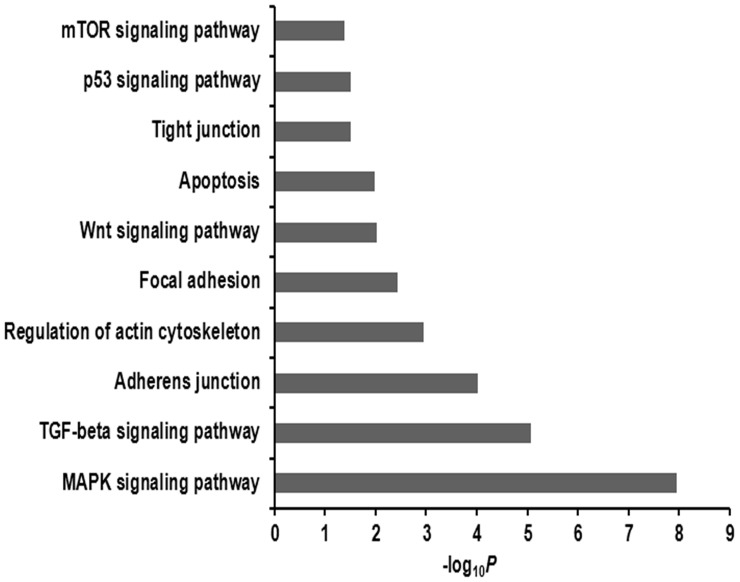
The KEGG pathways enriched for predicted targets of differentially expressed miRNAs.The negative log of the p value (−log10
P) was plotted on the x-axis.